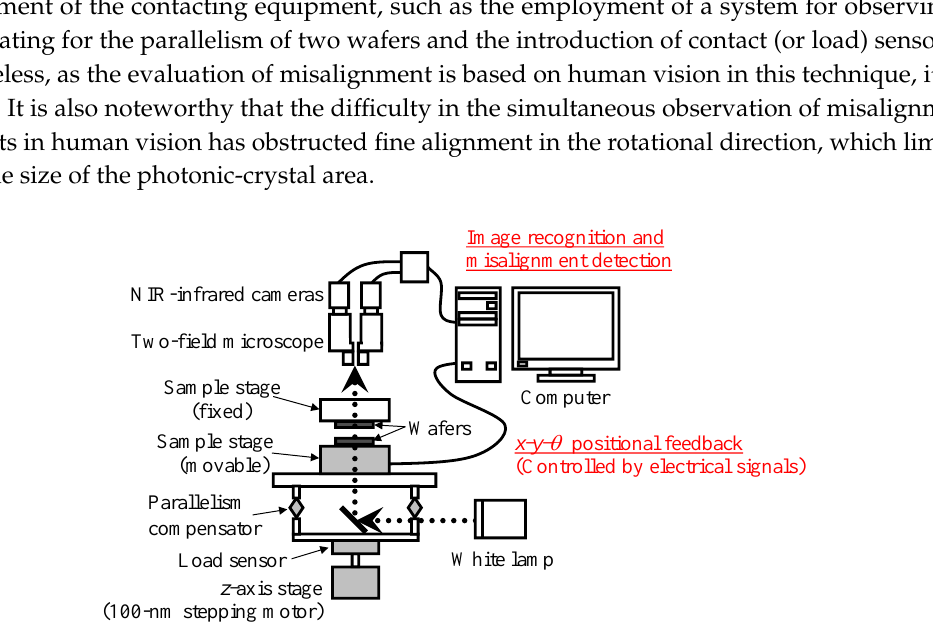
Figure 2. Schematic configuration of the automatic alignment and bonding setup.